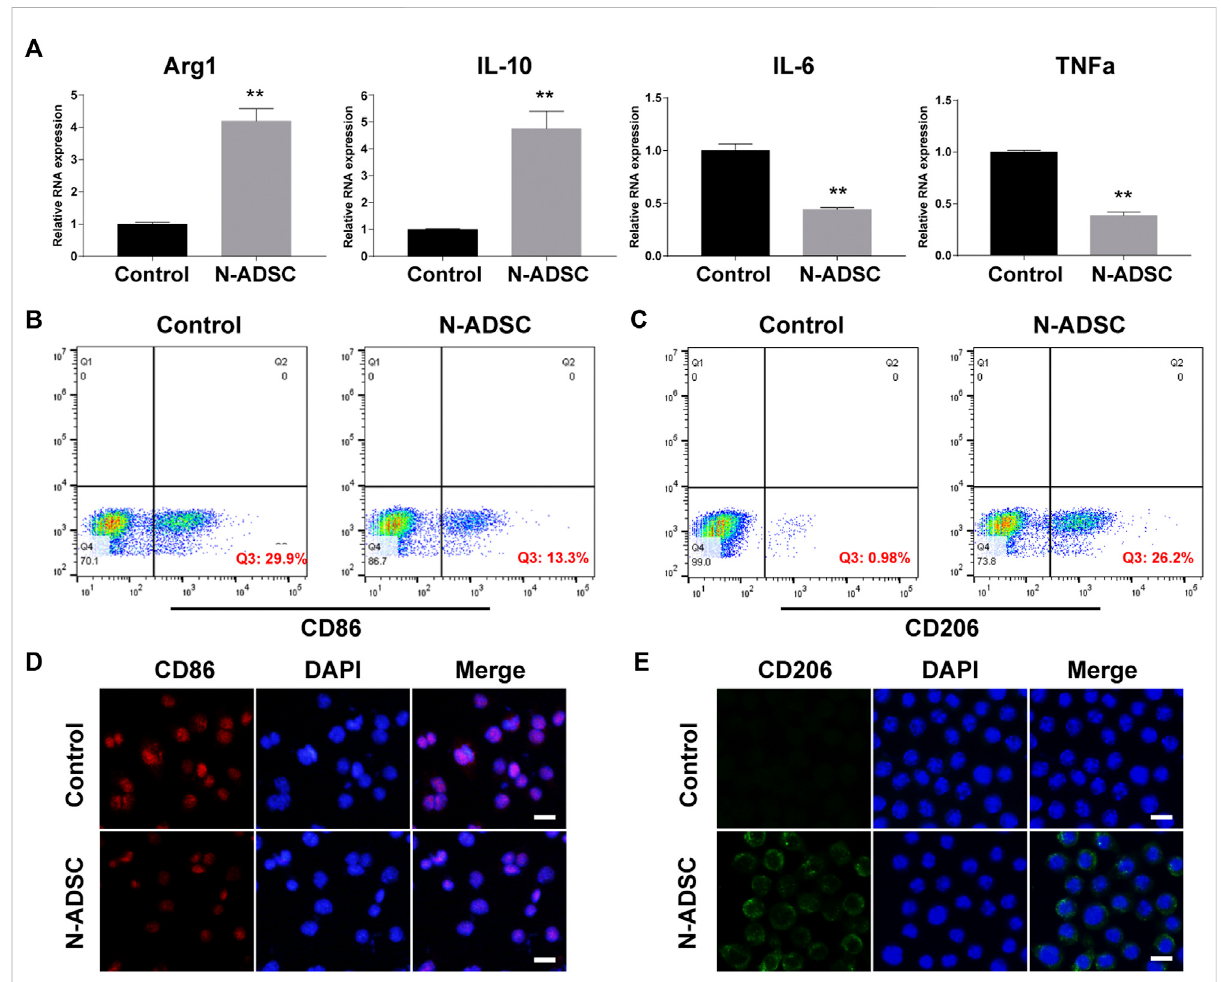
FIGURE 5 The effect ofN-ADSCs on macrophagepolarization invitro. (A) RT-qPCRofArg-1,IL-10,IL-6 and TNF- α from N-ADSCs-treatedmacrophages compared to DMEM-treated macrophages. (B,C) Addition of LPS and fl ow cytometry analysis of CD86 and CD206. (D,E) Immuno fl uorescence of CD86 and CD206. ** p < 0.01. Scale bar = 100 μ m. N-ADSCs, Netrin-1-modi fi ed adipose-derived stem